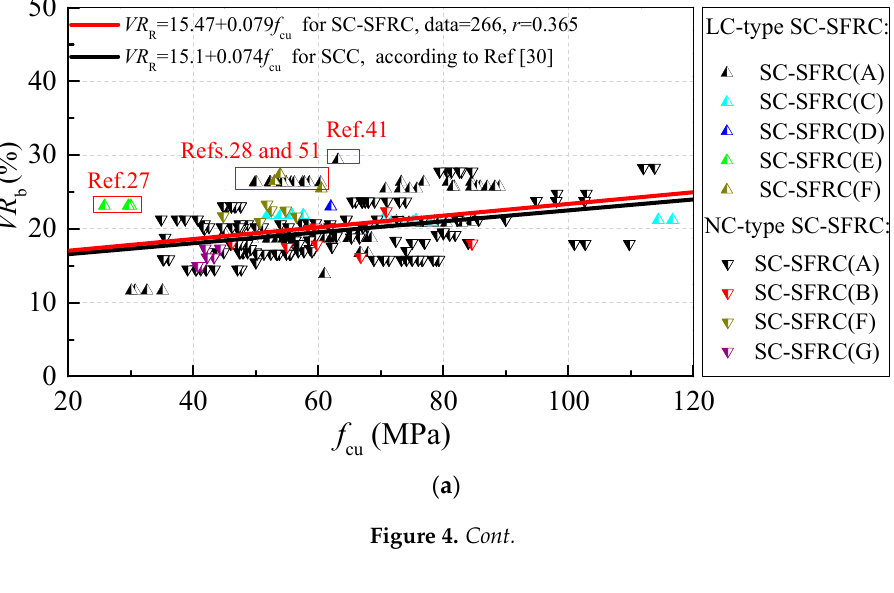
Figure 3. The probability distribution of maximum particle size of coarse aggregates.